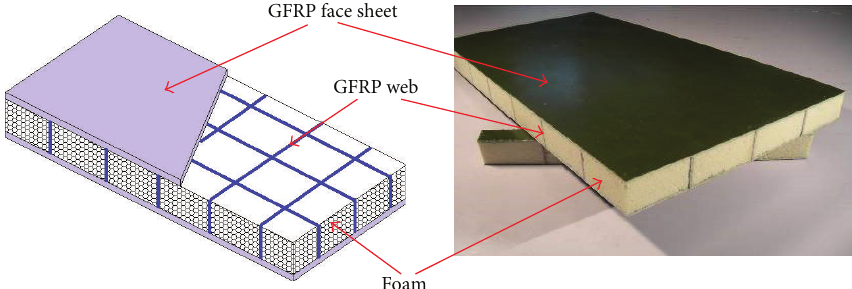
Figure 1: The sandwich bridge deck with GFRP face sheets and a foam-web core.